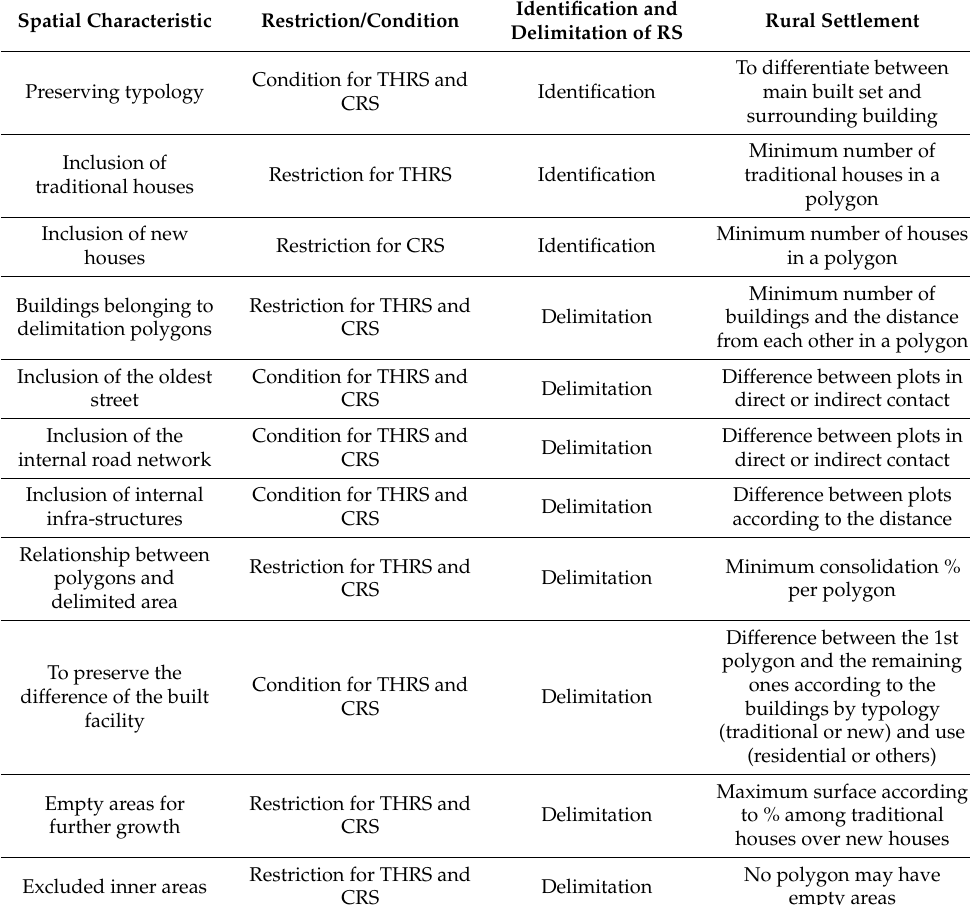
Table 3. Restrictions and conditions for identification and delimitation of a